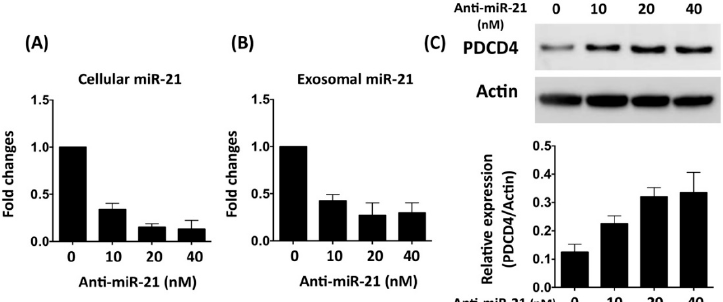
Figure 2. Reduced expression of exosomal miR-21 through transfection of anti-miR-21 in rat primary cardiomyocytes. ( A ) Real-time RT-PCR examination of expression levels of cellular miR-21 in neonatal cardiomyocytes 24 h after delivery of anti-miR-21 ( B ). Real-time RT-PCR examination of expression levels of exosomal miR-21 in neonatal cardiomyocytes 24 h after delivery of anti-miR-21. ( C ) Expression levels of PDCD4, the target of miRNA, in cardiomyocytes transfected with anti-miR-21. n = 3 for each